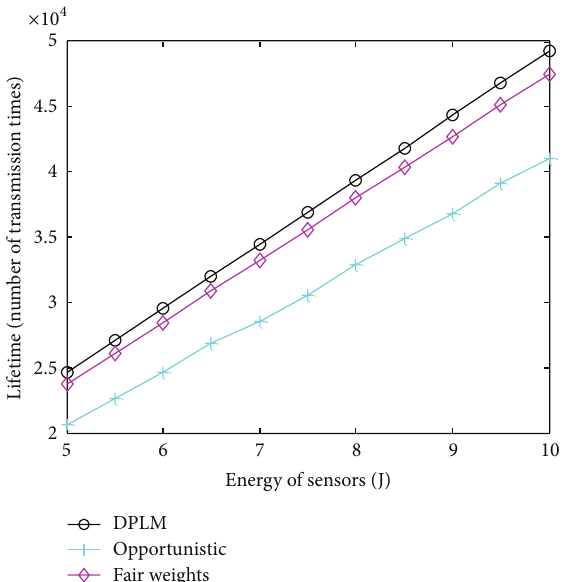
Figure 6: Lifetime versus energy of sensors achieved from pure opportunistic, DPLM, and fair weights scheme.